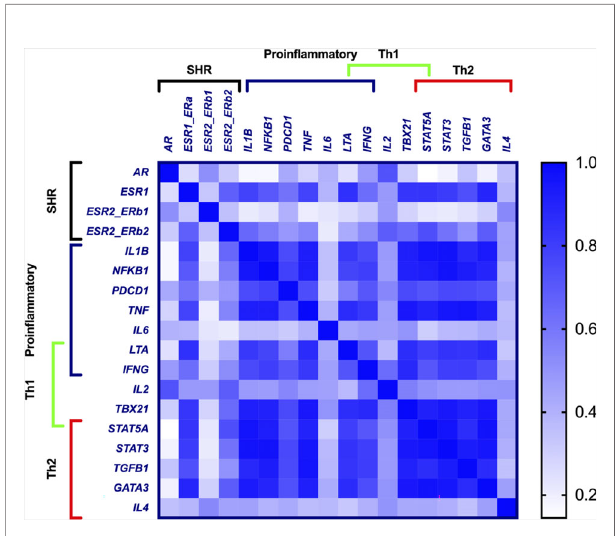
FIGURE 3 | A heatmap of repeated measures correlation coef fi cients between gene expressions in PBMCs from pre-MP women. Increased blue color represent increased correlation (r-value ! 1) ( n = 10, each sampled 4 times). Proin fl ammatory genes, SHR genes, and genes associated with T H 1, and T H 2 response are indicated. P -values are listed in Supplemental Table 3